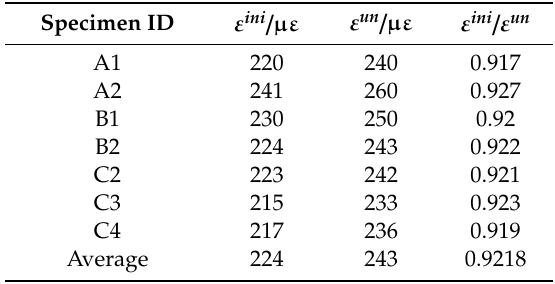
Table 3. Crack initiation and unstable propagation strain.